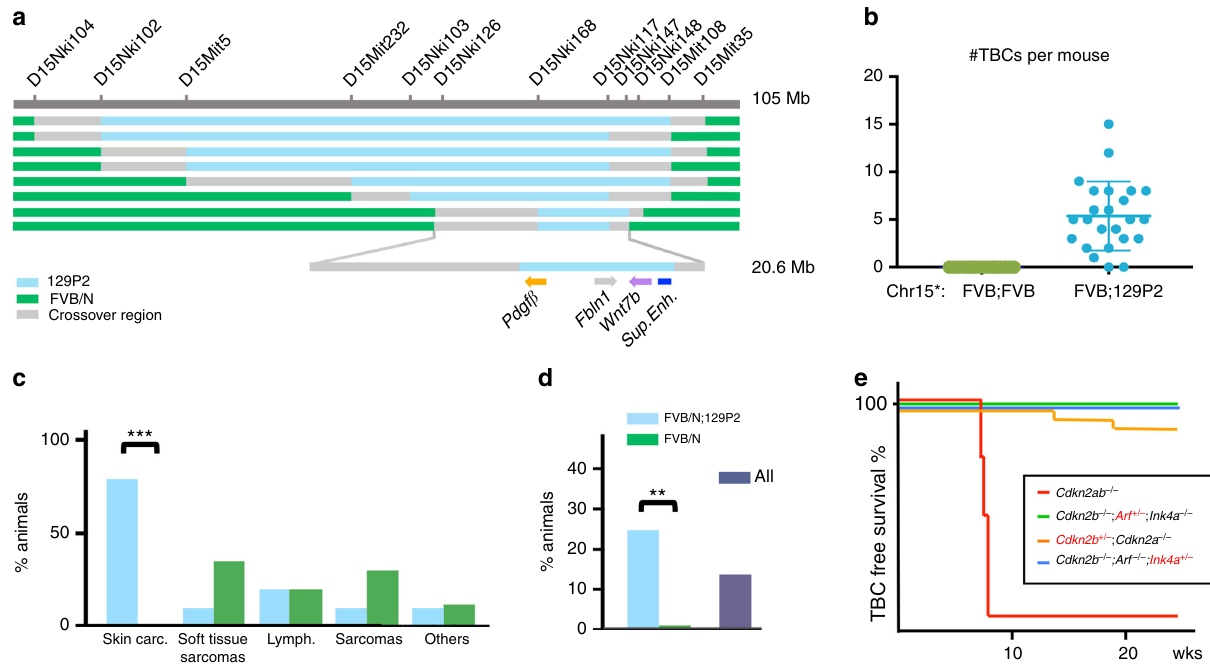
Fig. 3 Identi fi cation of the Chr15 79 – 87 Mb region having genetic linkage to the skin tumour phenotype. a Schematic of the recombined Chr15 with varying 129P2 and FVB/N background in skin tumour bearing mice (blue: 129P2, green: FVB/N background and grey: region of crossover); relevant microsatellite markers used are indicated on top; below a blowup of the relevant region). b Number of skin tumours on individual Cdkn2ab − / − mice homozygous FVB/N (green) Chr15 85 Mb or FVB/N;129P2 (blue) for region Chr 15 85 Mb (Chr15*). c Tumour spectrum of Cdkn2ab − / − mice as mentioned in b . d Frequency of squamous metaplasia in the lungs of Cdkn2ab − / − mice as mentioned in b . e Kaplan – Meier curve showing skin tumour-free survival of Cdkn2ab mutant mice FVB/N;129P2 for the Chr 15; 85 Mb region; red line: Cdkn2ab − / − : de fi cient for p15 Ink4b , p16 Ink4a and p19 Arf ; green: Cdkn2b − / − ;Arf + / − ;Ink4a − / − : de fi cient for p15 Ink4b and p16 Ink4a , pro fi cient for p19 Arf ; blue: Cdkn2b − / − ;Arf − / − ;Ink4a + /- : de fi cient for p15 Ink4b and p19 Arf , pro fi cient for p16 Ink4a ; orange: Cdkn2b + / − ; Cdkn2a − / − : de fi cient for p16 Ink4a and p19 Arf , pro fi cient for p15 Ink4b . Statistical analysis (Unpaired t- test): ns: ** p < 0.01, *** p <